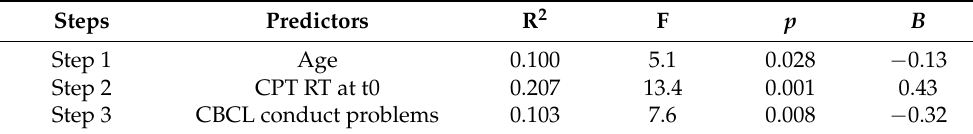
Table 5. Hierarchical linear regression model predicting CPT RT at t1 after MPH